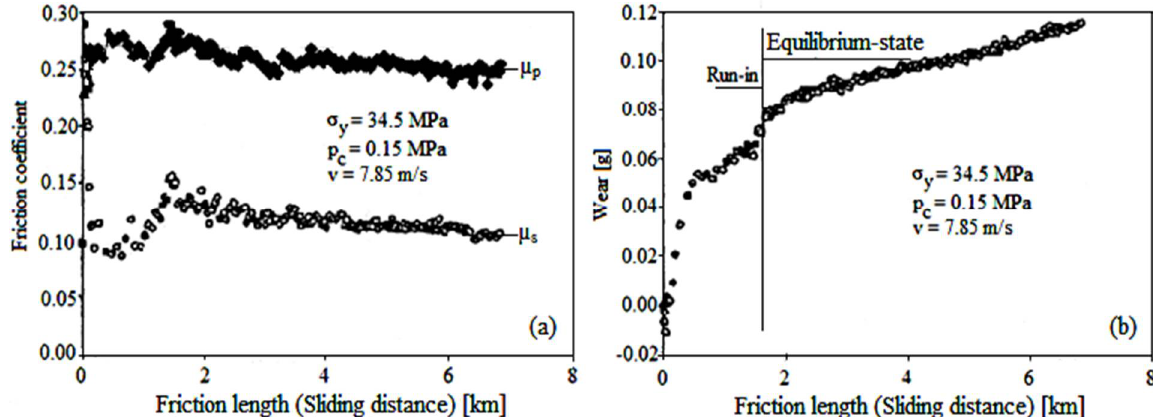
Figure 4. Experimental results on frictional and wear behavior of slider pad/disk in same conditions of tension, σ y , pressure, p c , and velocity, v: friction coefficient variation ( a ) and of wear intensity gravimetrical ( b ) depending on friction length (sliding distance). Noted: The friction coefficient, μ p , and μ s were determined from the ratio, μ p = F’ t /F p , respectively, the ratio, μ s = F t /F s (F’ t and F t — friction forces, measured at the pellet base and of slider pad base, respectively, F p and F s —normal load of the pellet and of the slider pad (see Figure 1)).